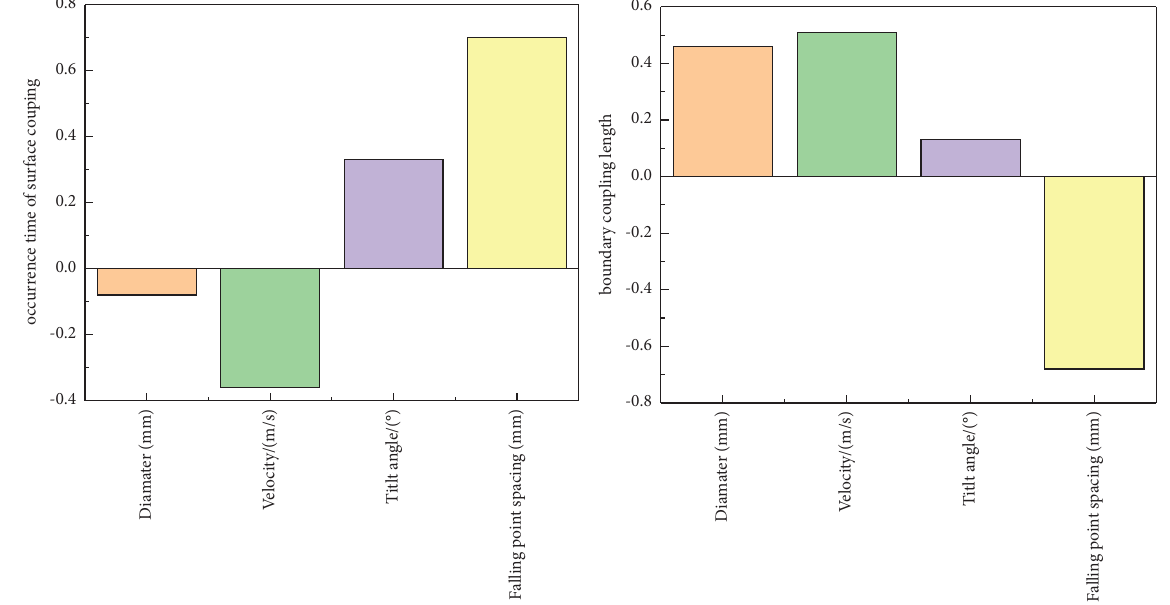
Figure 13: Normalized regression coefcient of surface joint occurrence time and boundary joint length.